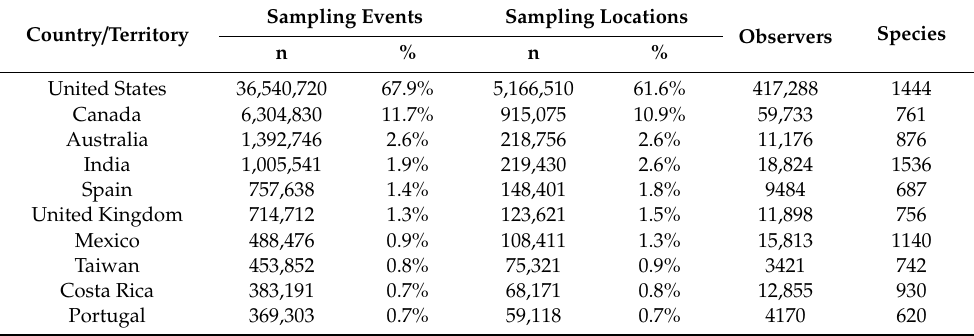
Table 1. Top 10 countries and territories most intensively sampled by eBird